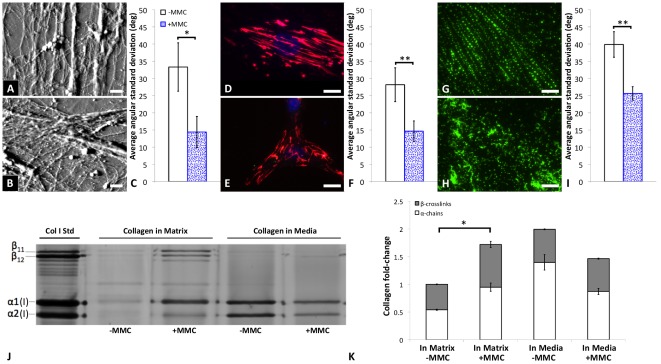
Macromolecular crowding induces alignment of extracellular matrix fibers and an increase in deposition of collagen type-I in human bone marrow-derived mesenchymal stromal or stem cells (MSCs).(A) Atomic force microscopy (AFM) contact mode deflection images of extracellular matrix deposited by MSCs left behind after detergent removal of cells in media containing macromolecular crowders (+MMC media) and (B) −MMC media after 7 days. Scale bars = 2 mm. (C) Average angular standard deviation for AFM imaging of extracellular matrix in A and B (N = 5 +MMC, N = 5 −MMC, p = 0.1363). (D) Immunostaining of extracellular fibronectin (red) and cell nucleus (blue, DAPI) for +MMC and (E) −MMC in MSCs after 3 days of culture. Scale bars = 30 µm. (F) Average angular standard deviation for fibronectin in D and E (N = 15 +MMC, N = 11 −MMC, p = 0.0013). (G) Immunostaining of extracellular collagen IV (green) and cell nucleus (blue, DAPI) +MMC, (H) and −MMC, in hMSCs after 3 days of culture. Scale bars = 15 mm (I) Average angular standard deviation for collagen IV in G and H (N = 12 +MMC, N = 8 −MMC, p = 0.0253). Lower values of average angular standard deviation indicate a higher degree of alignment of fibers comprising the extracellular matrix. (J) Western blot of collagen type-I secreted by human bone marrow-derived mesenchymal stromal or stem cells after 48 hrs in culture medium ± MMC demonstrates a significant increase in the cell deposited collagen into the matrix +MMC. (K) Normalized densitometry of collagen type-I Western blot demonstrates a shift in collagen distribution from media to matrix, indicative of the enhanced deposition of collagen in the presence of MMCs. Significant increases in crosslinked collagen α-chains (β-bands) is observed in the cell deposited matrix +MMC, as compared to −MMC conditions (p<0.0001). Values are reported as mean ± standard error of measurement. * indicates p = 0.1363; and ** indicates statistical significance (p<0.05).